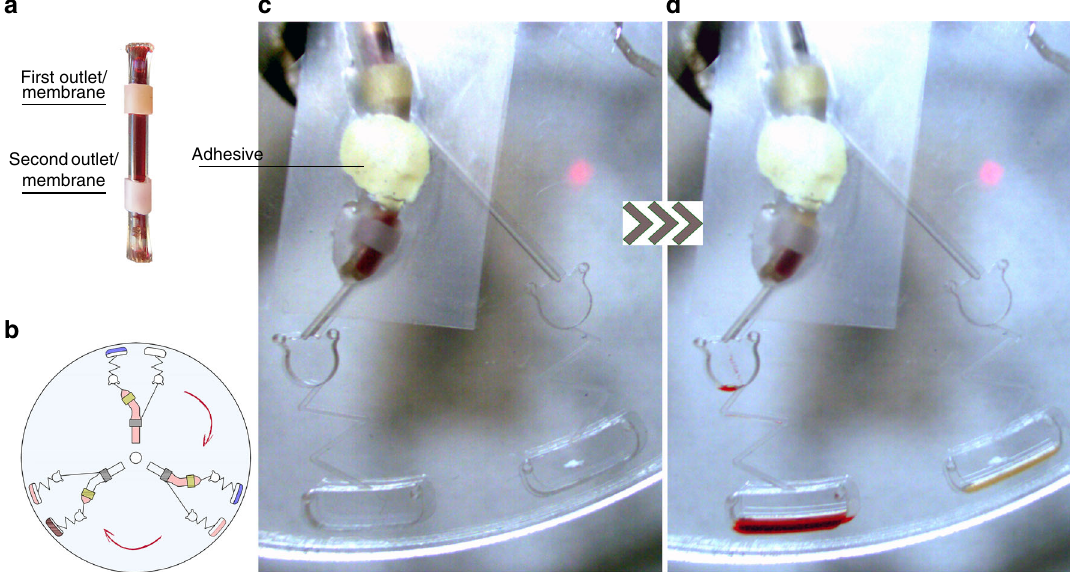
Fig. 3 Images of a rotating lab-on-a-disc with micro-dispenser insert enabling separation of blood components. a Micro-dispenser with two apertures covered with C- fl ex and latex membranes, b schematic of the lab-on-a-disc platform used in the experiment, c before actuation of the micro-dispenser, d dispensing blood plasma and blood cells to two different destination chambers, at different rotational frequencies due to the difference between the membrane properties of the micro-dispenser